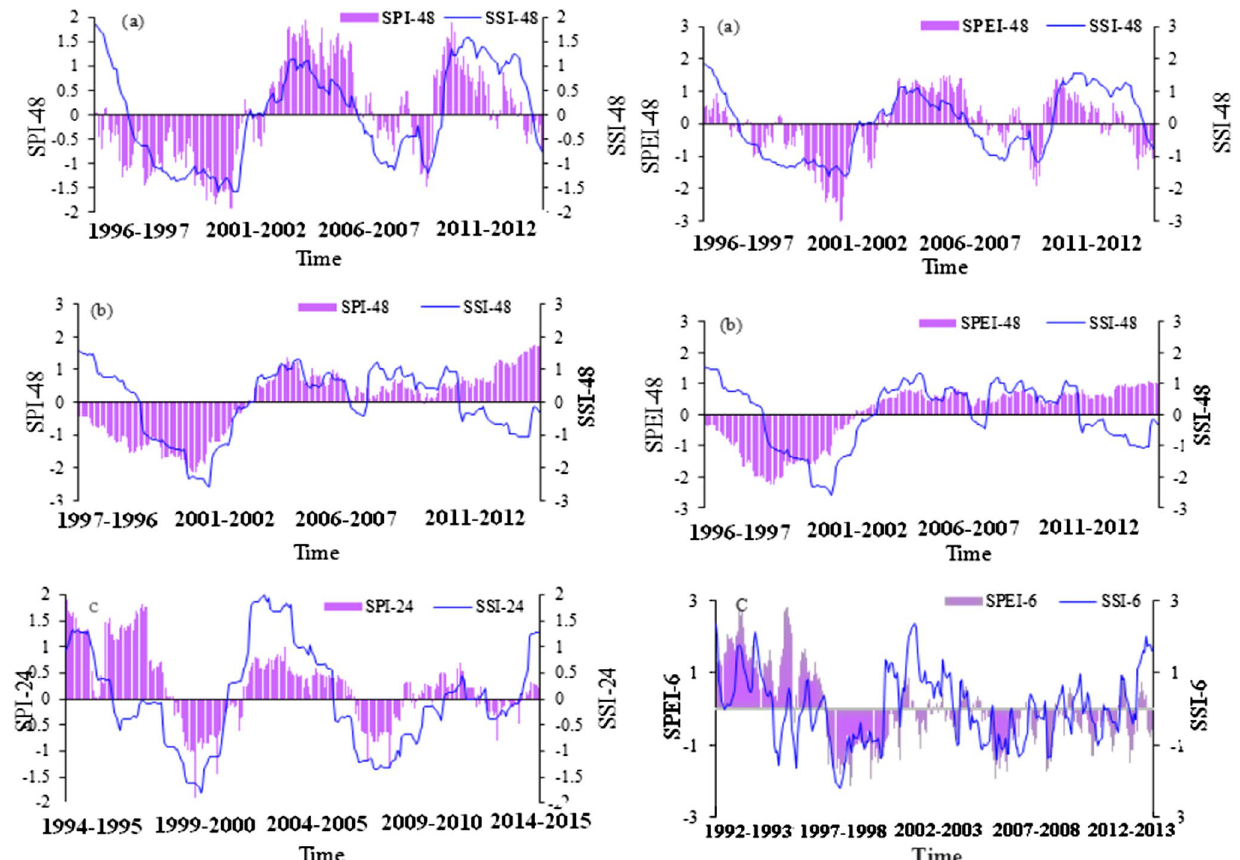
Fig. 5 Time series of drought indices with high cross-correlation coefficient in the a Navroud, b Lighvan, c